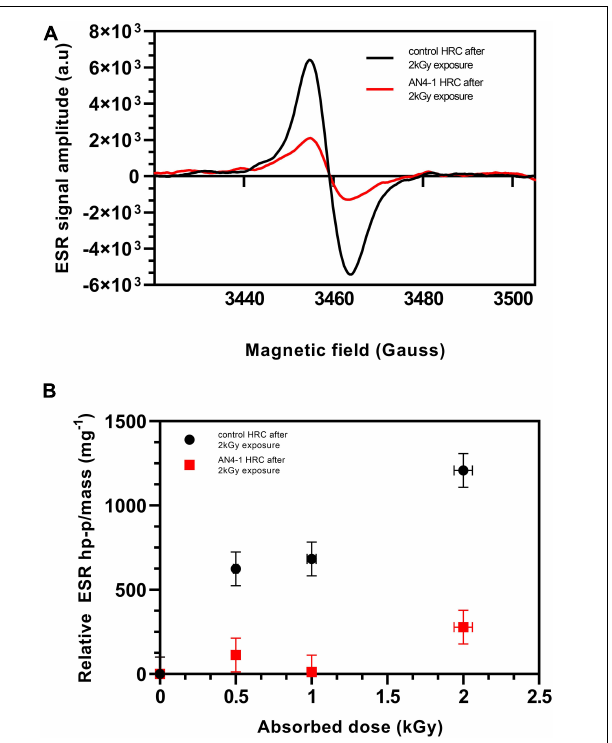
FIGURE 8 | ESR spectra of AN4-1 and control HRCs gamma-irradiated at 2 kGy absorbed dose (dose rate = 1.8) (A) . ESR kGy water/h signal intensity of white and purple HRCs gamma are reported as a function of the absorbed dose (up to 2 kGy absorbed dose; dose rate = 1.8 kGy water/h) (B) . The intensity of each signal is expressed as the peak-to-peak height normalized for mass units and by subtracting the intensities of the HRCs signals before